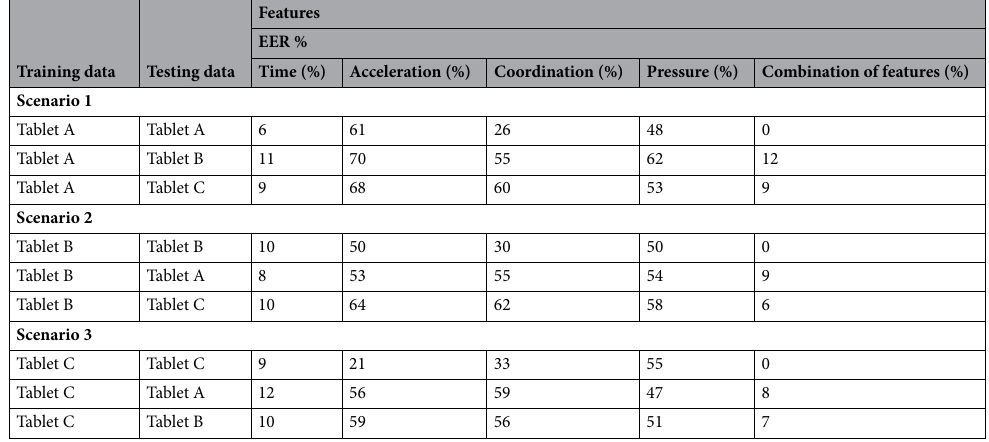
Table 4. Each feature’s error rates.